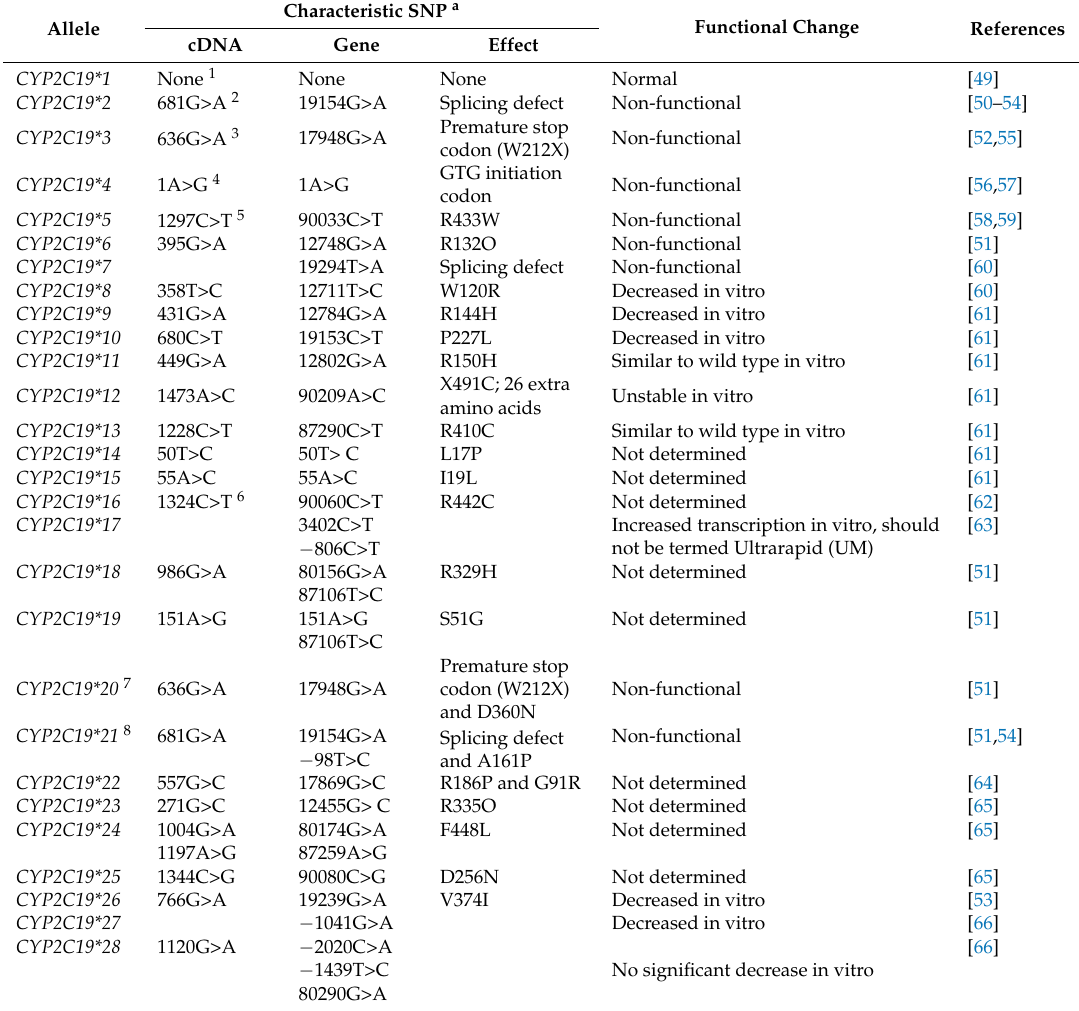
Table 1. Variants of CYP2C19 . Used with permission of Creative Commons; copyright 2012 [47].